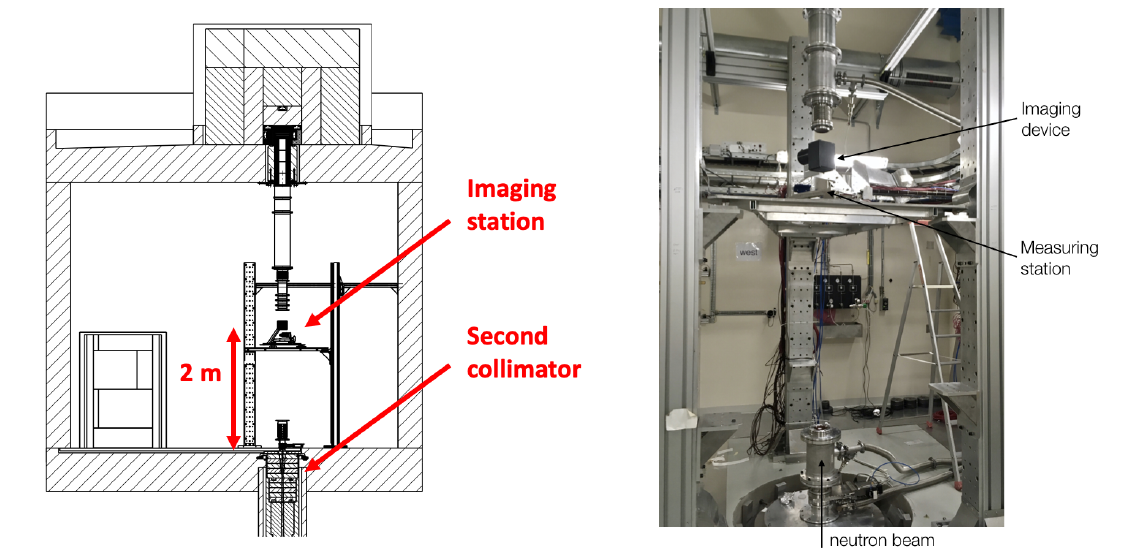
Figure 3. Scheme ( left ) and picture ( right ) of the n_TOF Experimental Area 2 bunker setup for neutron imaging